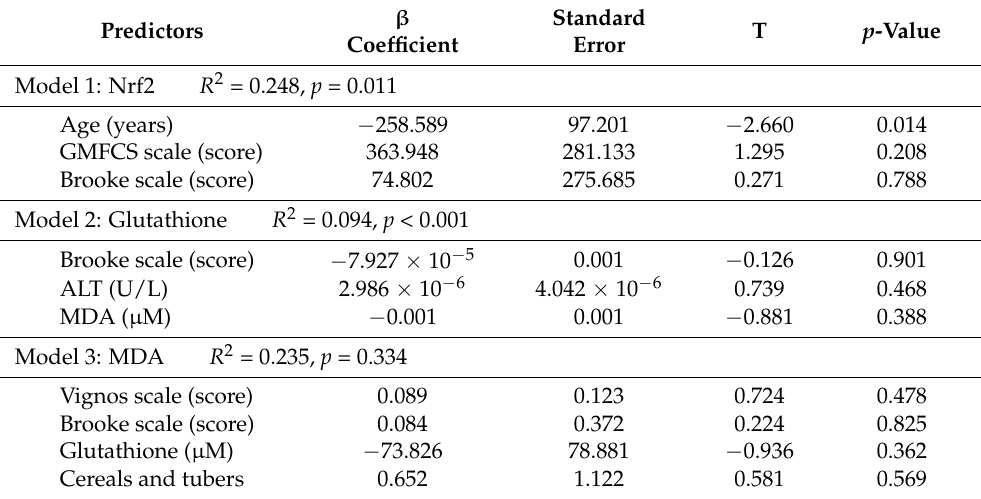
Table 4. GLM Univariate analyses to evaluate predictors of circulating markers of OS in DMD